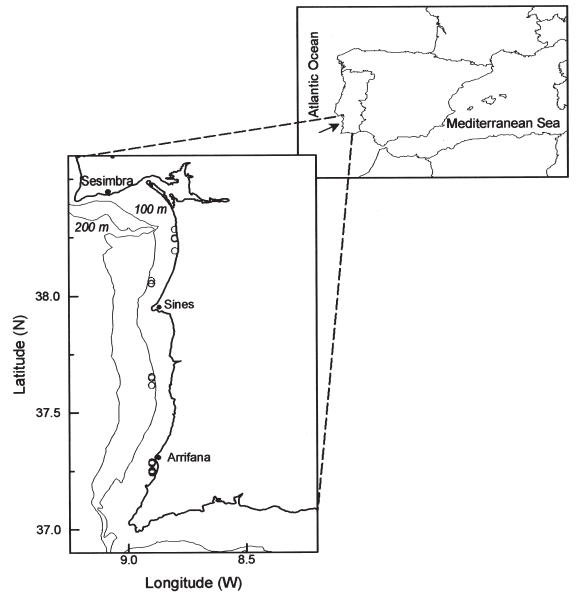
Fig. 1. – Location of selectivity hauls.